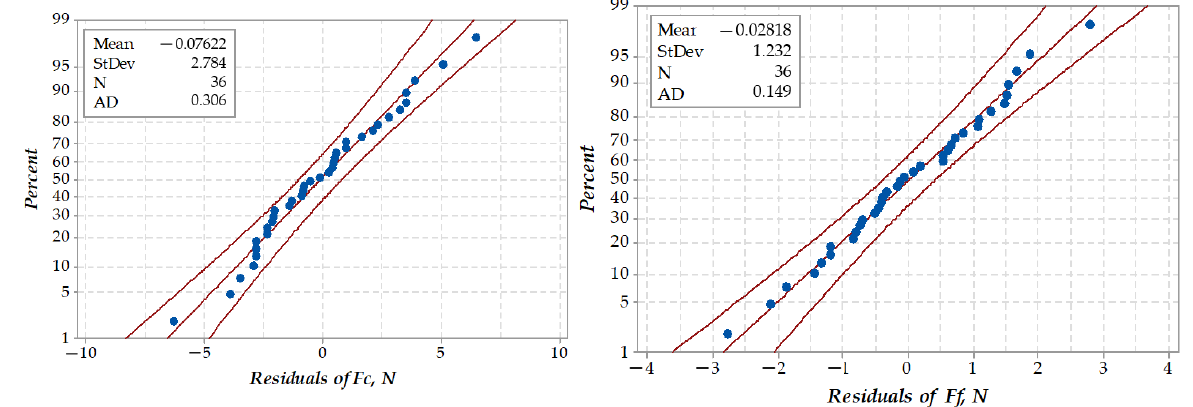
Figure 6. The investigation of the residuals on probability plots.